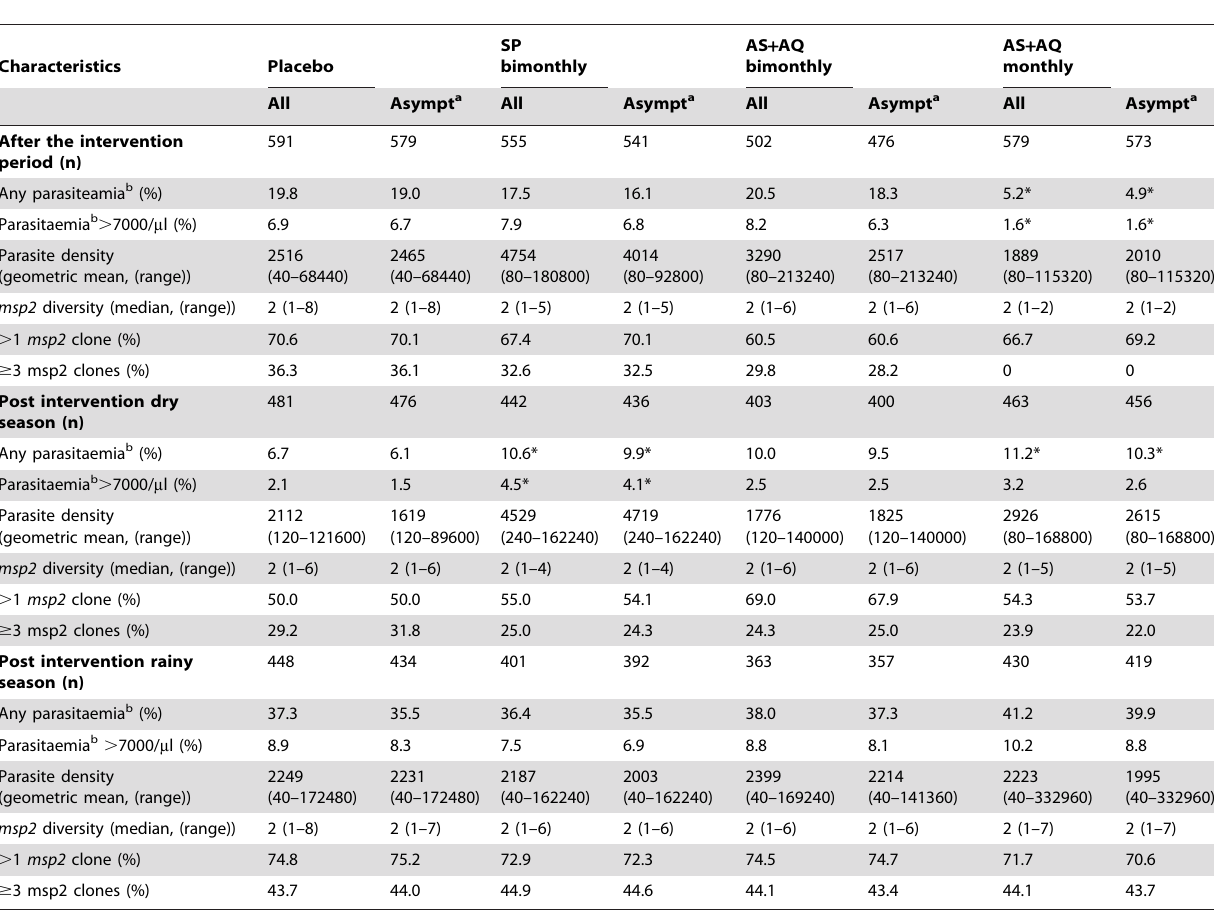
Table 1. Parasitological findings at three cross-sectional surveys following a 6 months intervention period with different IPT